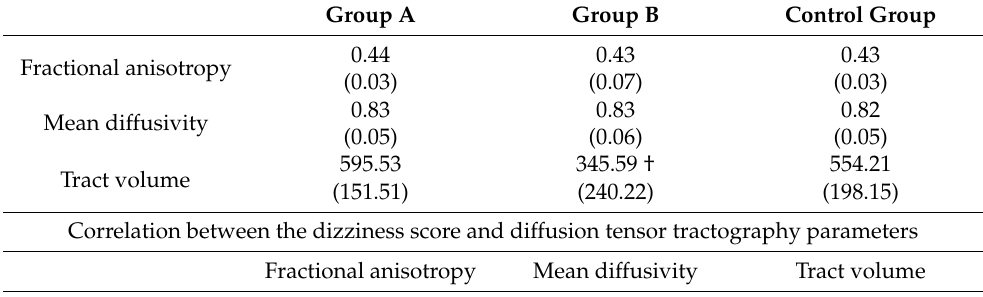
Table 2. Diffusion tensor tractography parameter values of the core vestibular projection of the patient and control groups.